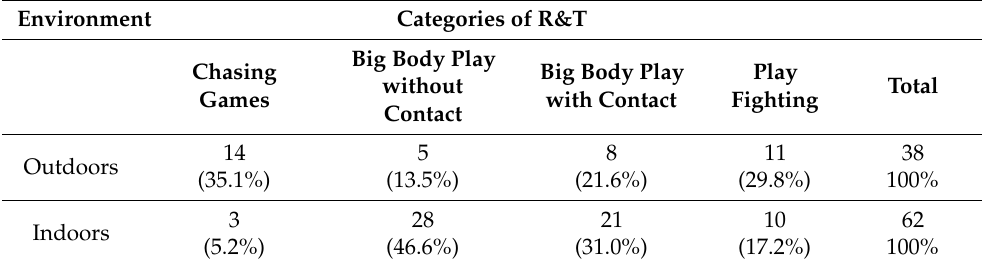
Table 2. The environments in which R&T